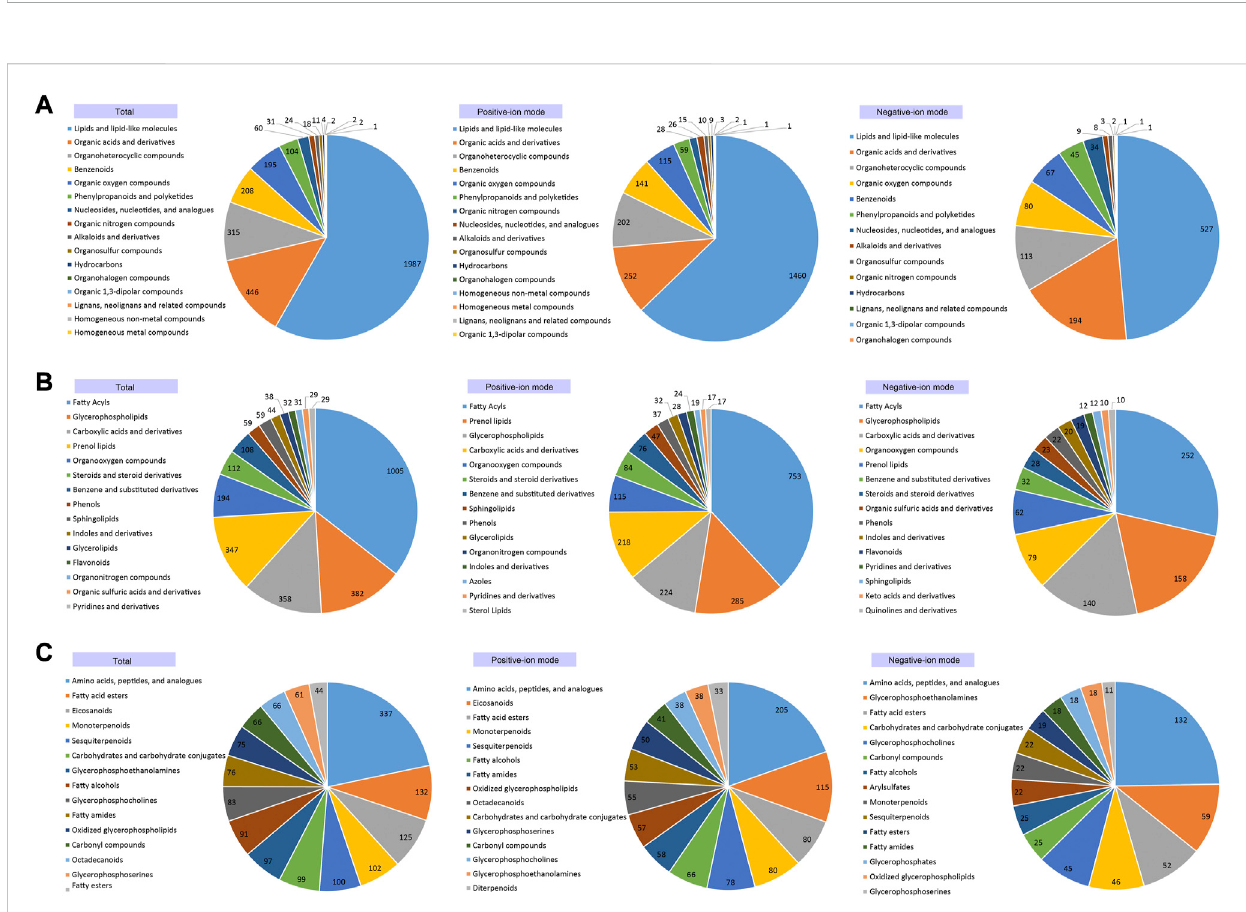
FIGURE 3 Annotated cochlear metabolites detected for Super-classi fi cation (A) , Classi fi cation (B) and Sub-classi fi cation (C) ,